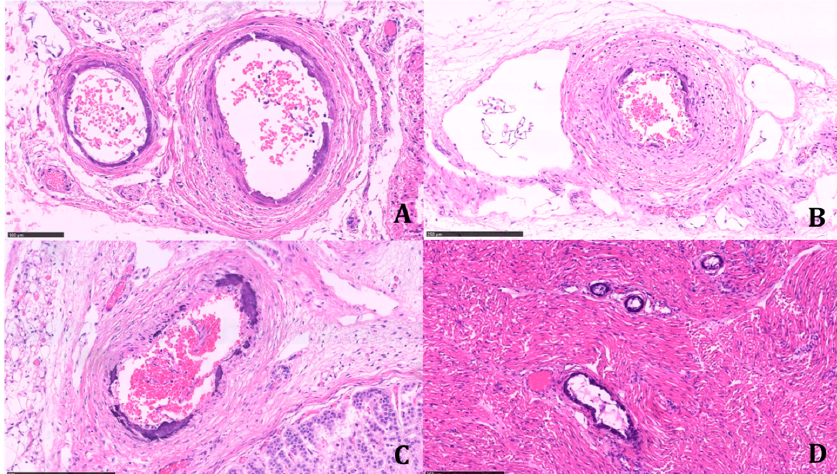
Figure 3. Systemic involvement of small arterial vessels. ( A ) Periaortic retroperitoneal vessels (H&E; 23.1×). ( B ) Retroperitoneal artery interposed between the adrenal gland and kidney (H&E; 16×). ( C ) Periadrenal artery (H&E; 17.9×). ( D ) Intramuscular arteries of various calibers (ileo-psoas muscle) (H&E; 13×). All histological preparations were digitized and photographed with Nanozoomer 360, Hamamatsu. (Scale bars: A: 100 µ m; B: 250 µ m; C: 250 µ m; D: 250 µ m).